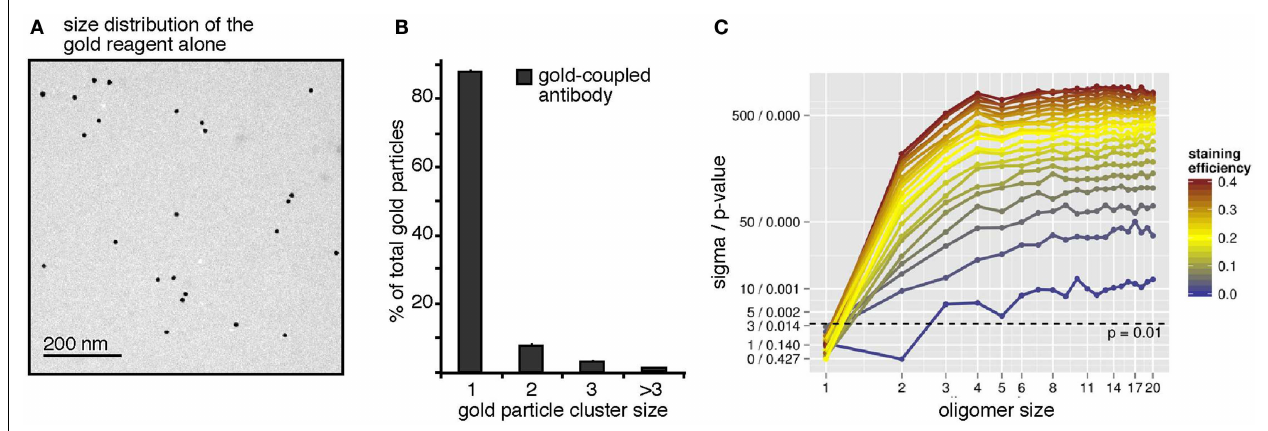
staining. Pre-clustering of the gold-reagent was taken into account. For different assumed receptor oligomer sizes ( x -axis) and staining efficiencies (color scale), significance level and p -value were computed ( y -axis). Models are rejected above the dashed line corresponding to a p -value of 0.01.The analysis confirms the monomer hypothesis and rejects other hypotheses with p < 0.01 (above the dashed line) for staining efficiencies larger